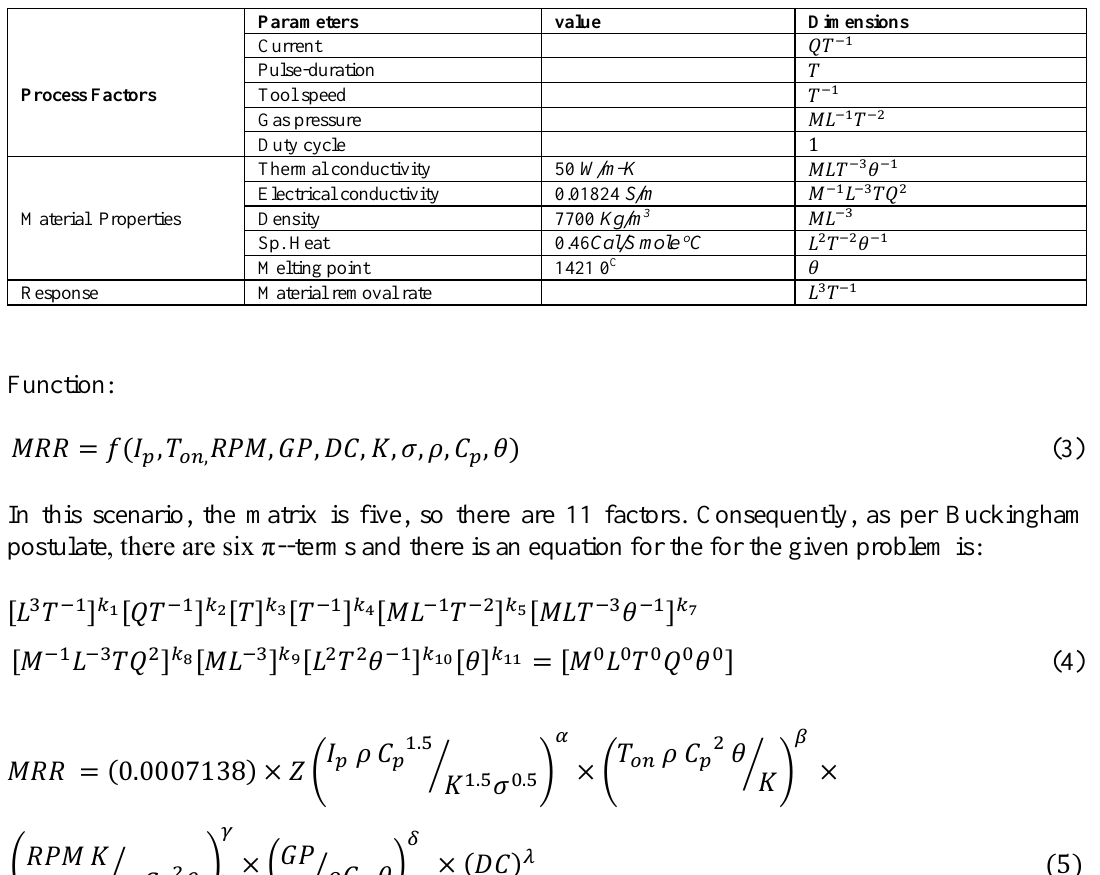
Table 5. Various attributes of physical